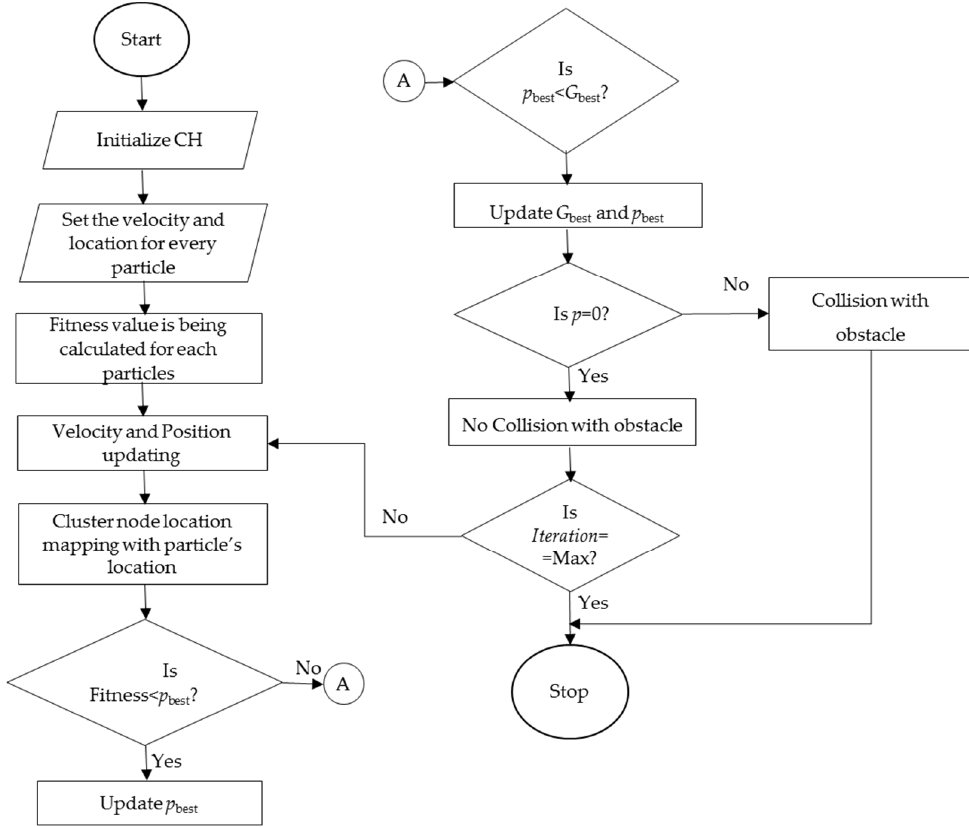
Figure 6. CH determination using PSO.